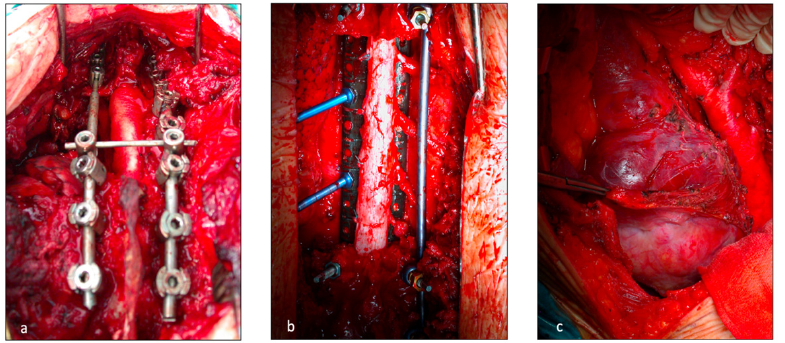
Figure 1. Operative field during vertebral resection and posterior spinal fixing. T ( a ) posterior release of the spinal cord at C7 ‐ D3 level; ( b ) Release of the spinal cord at D4 ‐ D9 levels; ( c ) left thoraco abdominal incision for spinal involvement at D11 ‐ L2 levels to prevent liver injuries.